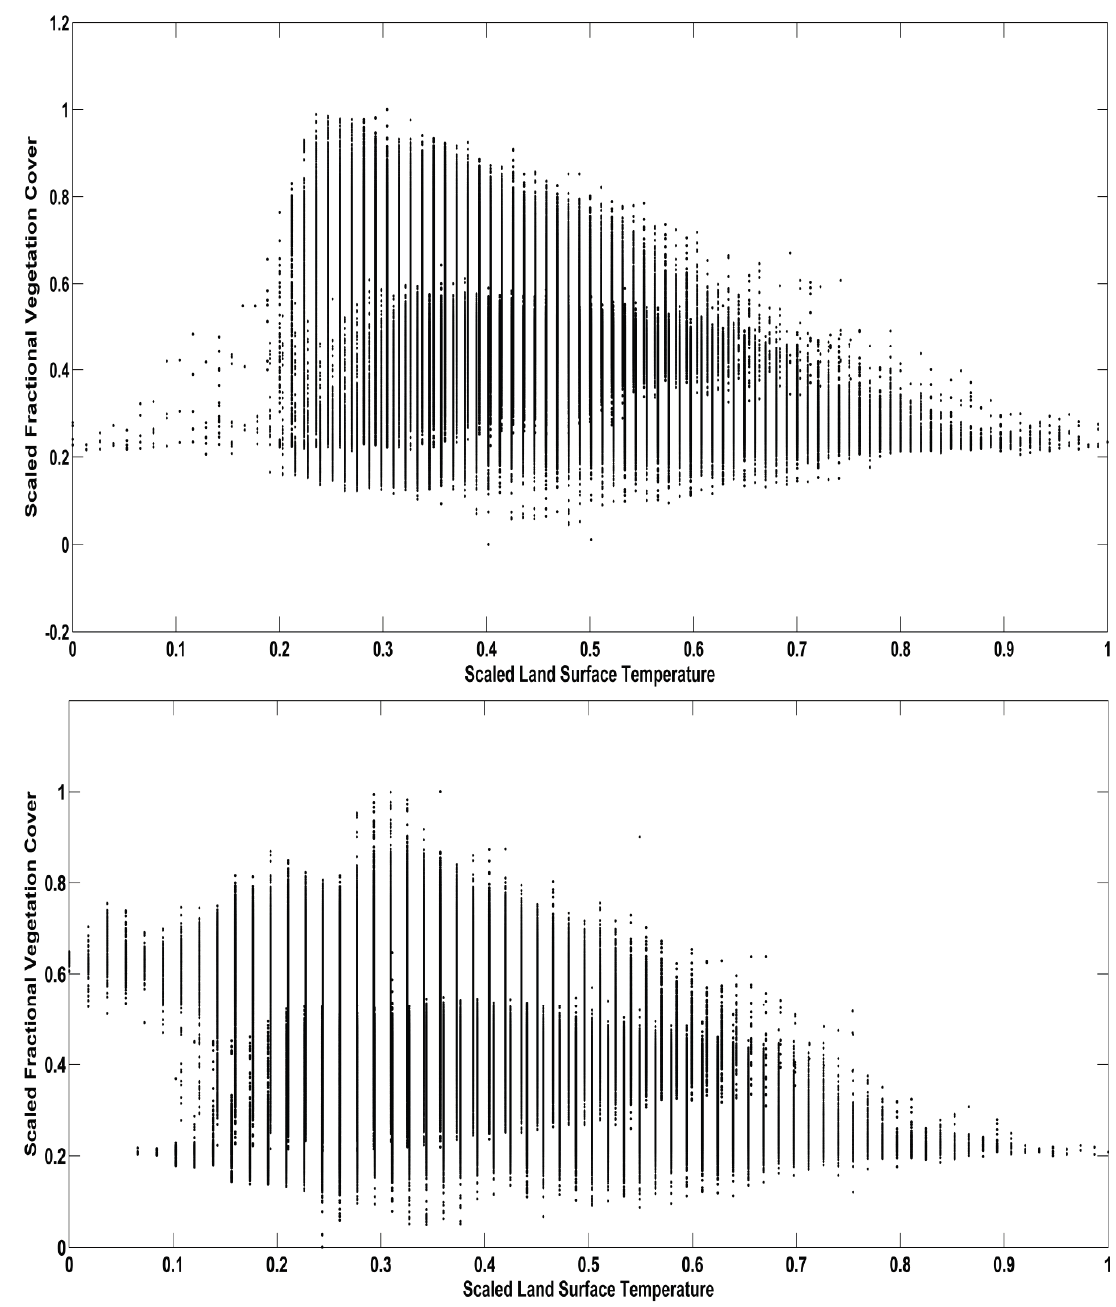
Figure 6. Scatterplot of scaled LST (x axis) versus scaled fractional vegetation cover (y axis) for Landsat TM images that was acquired on 17 June 2001 and 1 July 2006. Compared to the shape of the scatter plot in 2001( upper ), 2006 one ( lower ) became “shorter” and “wider”, which indicated the general trend of the surface condition changed to lower vegetation cover, lower moisture availability, and higher temperature. The scaled LST was transformed from LST by Equation (8) using maximum, minimum, and average LST. The scaled fractional vegetation cover was transformed by the same